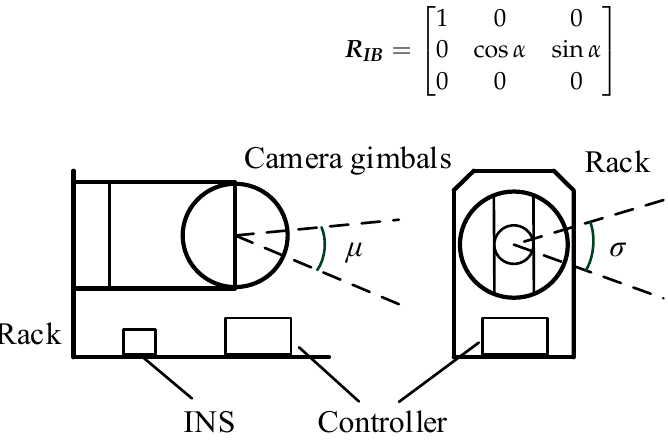
Figure 2. The structure of the camera stabilized platform.